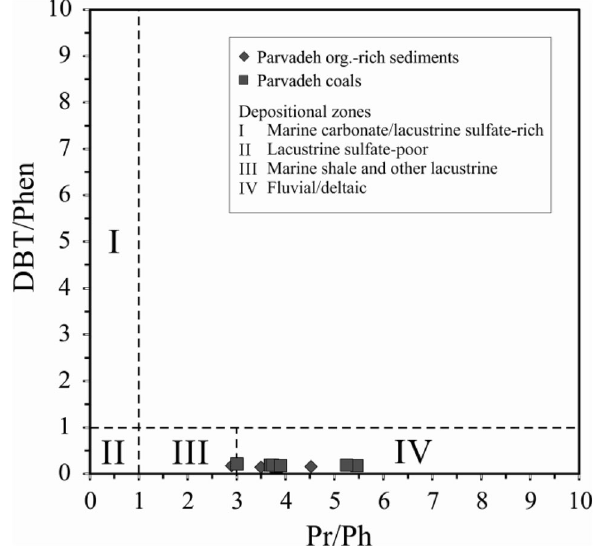
Fig. 9 Organic-rich sediments and coal samples of the Parvadeh coalfield plotted in the DBT/Phen against Pr/Ph diagram of Hughes et al. (1995) showing the depositional